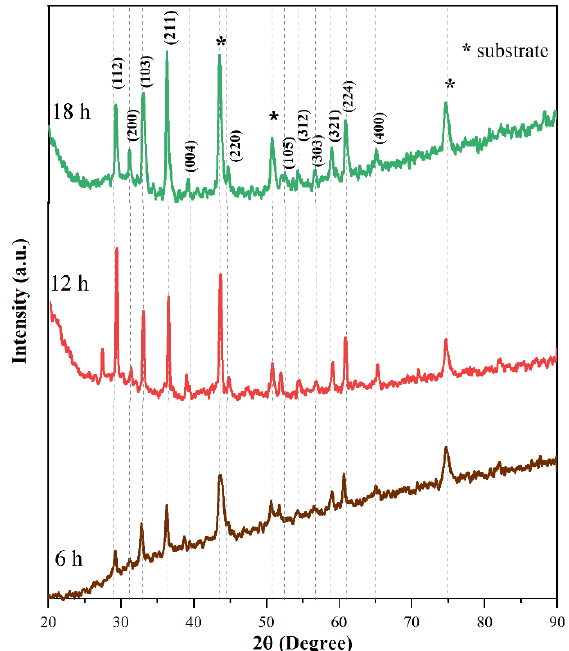
Figure 1. XRD patterns of ZnMn 2 O 4 obtained at different times, 6 h (brown), 12 h (red), and 18 h (green).